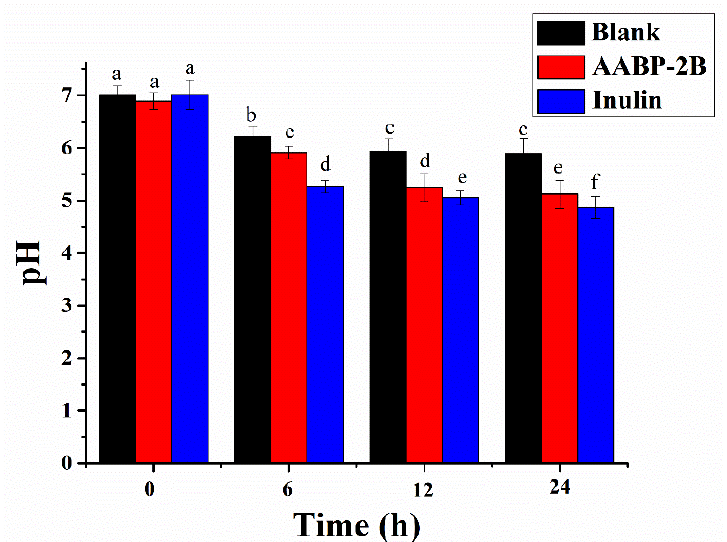
Figure 5. Changes in pH in AABP-2B and inulin groups during fermentation. Statistically significant differences were observed between different letters ( p < 0.05). Blank, without-carbon-source group; AABP-2B, indigestible A. asphodeloides polysaccharide (AABP-2B)-treatment group; IN, inulin-treatment group.